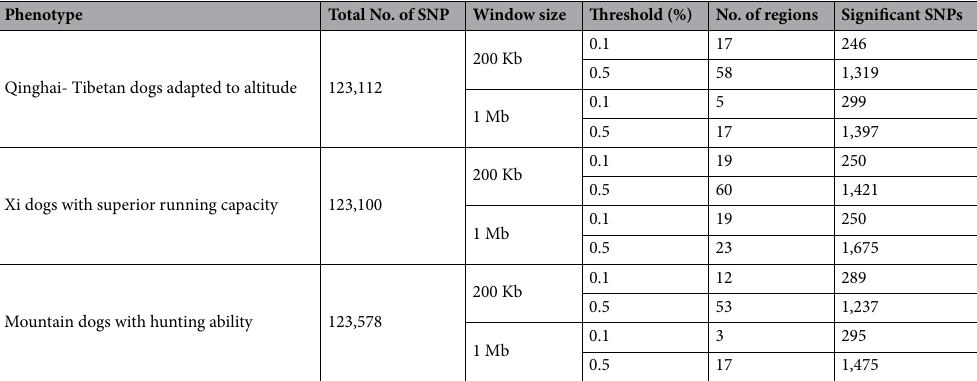
Table 1. Summary of the significant SNPs from CSS